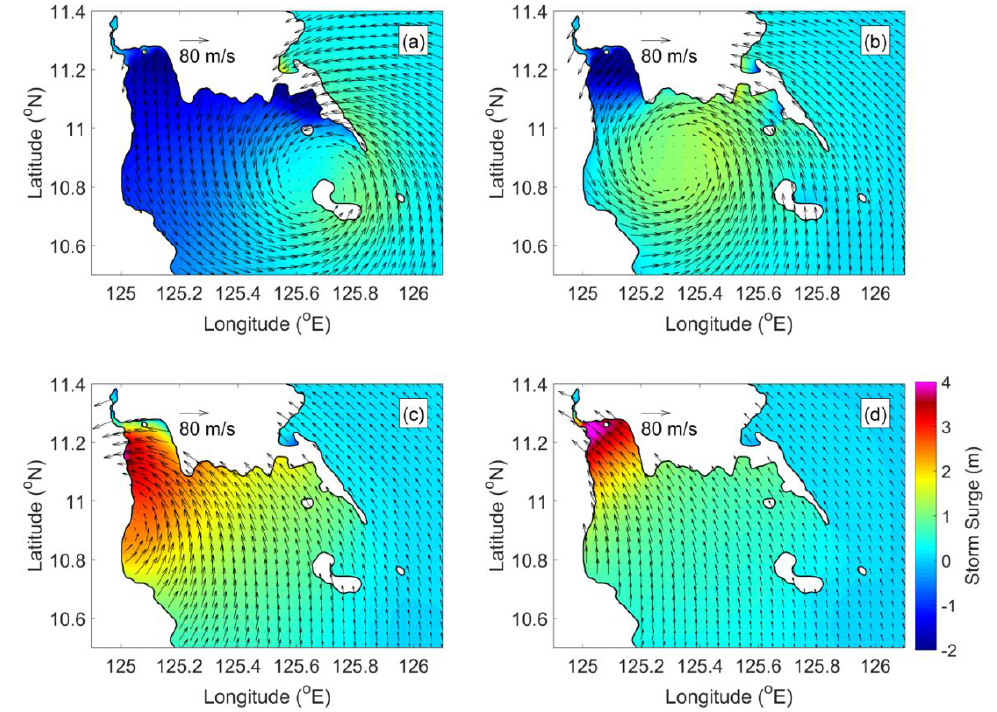
Figure 6. Snapshots of the computed storm surges driven by HWM at: ( a ) 21:30 UTC 7 November 2013; ( b ) 22:30 UTC 7 November 2013; ( c ) 23:30 UTC 7 November 2013; ( d ) 00:30 UTC 7 November 2013. The color shading indicates the storm surge in m and the black line depicts the coastline of the storm surge model. The arrows depict the 10-m winds of HWM per every 15 grids over the domain. These snapshots have been zoomed in from the original computational domain.